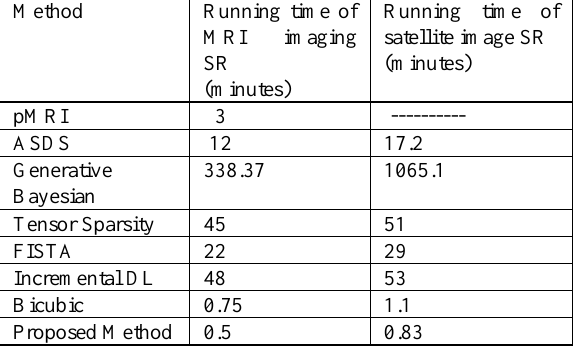
Table1. Represents running time of SR algorithms